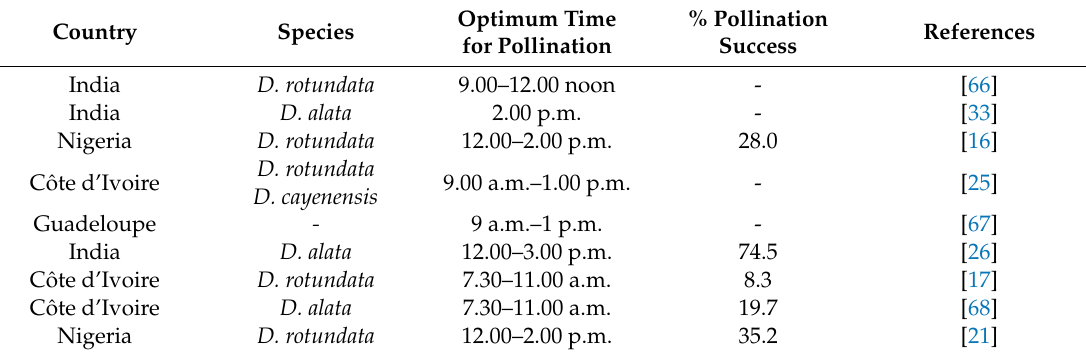
Table 2. Recommended pollination times for di ff erent yam growing